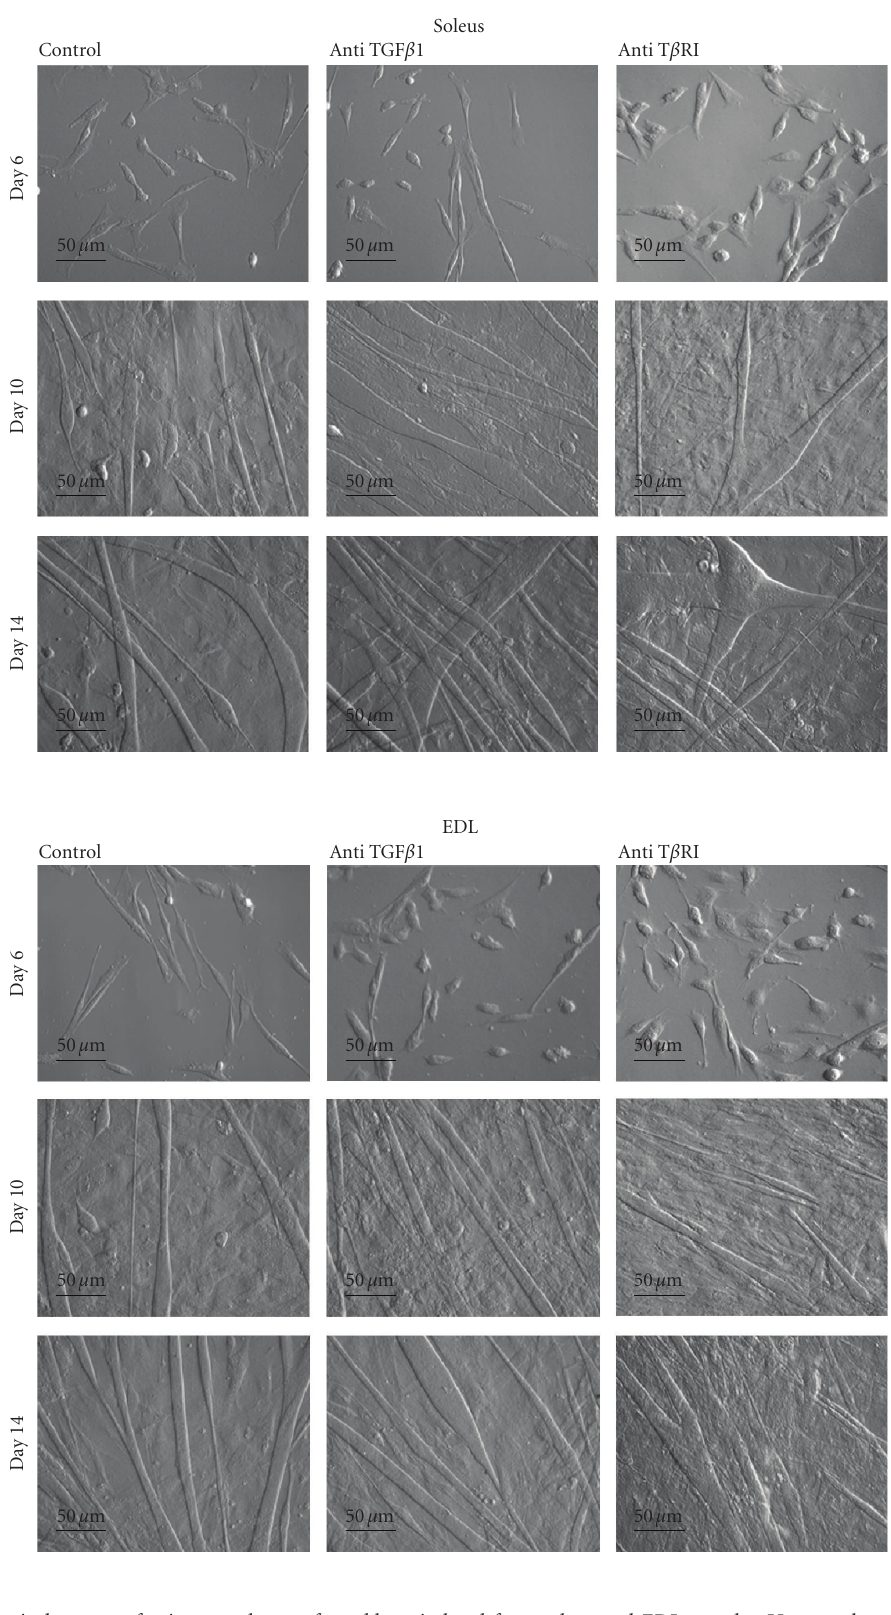
Figure 5: Morphological aspects of primary cultures of myoblasts isolated from soleus and EDL muscles . Untreated myoblasts (control) or myoblasts treated at day 4 with either anti-TGF β 1 or anti-T β RI antibody were cultured as described in the Materials and Methods Section. Observations were performed at the indicated days after plating using an Ho ff man contrast objective. Bars: 50 μ